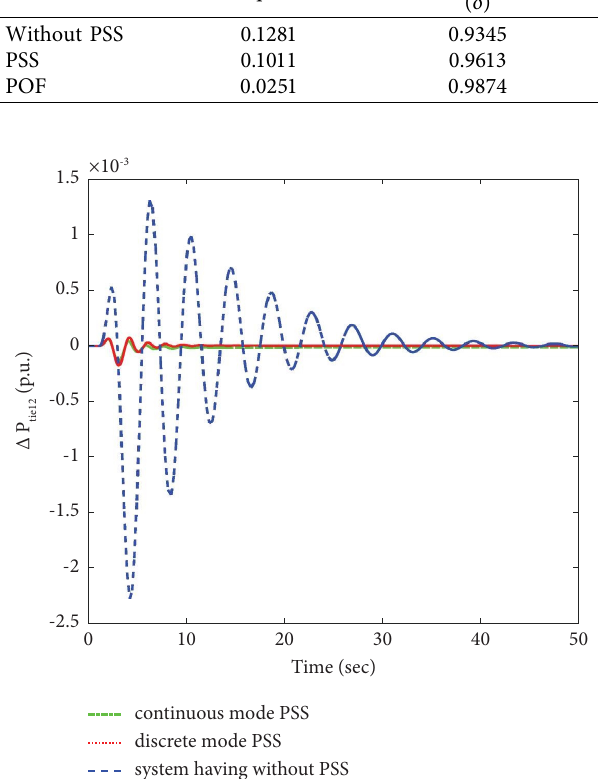
Figure 2: Power deviation in tie-line Δ P tie12 (p.u.) with respect to time (sec) for without having any PSS, with the continuous PSS, and with the discrete lead-lag-based